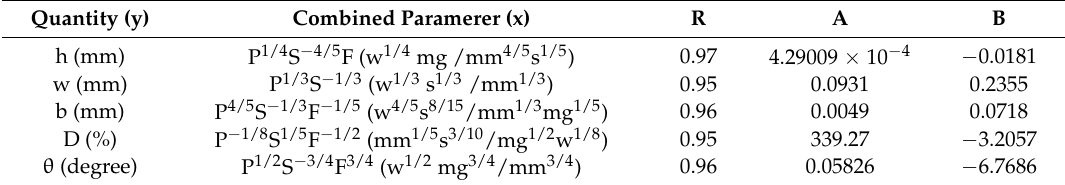
Table 3. All predicted combined parameters of single clad tracks in the present study.